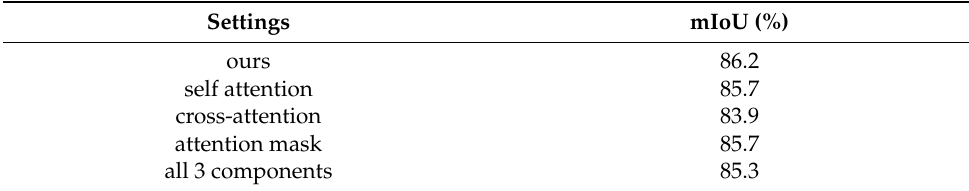
Table 4. Effect of the component in the transformer decoder. Figure 7. Ablation studies on the number of object embedding queries.